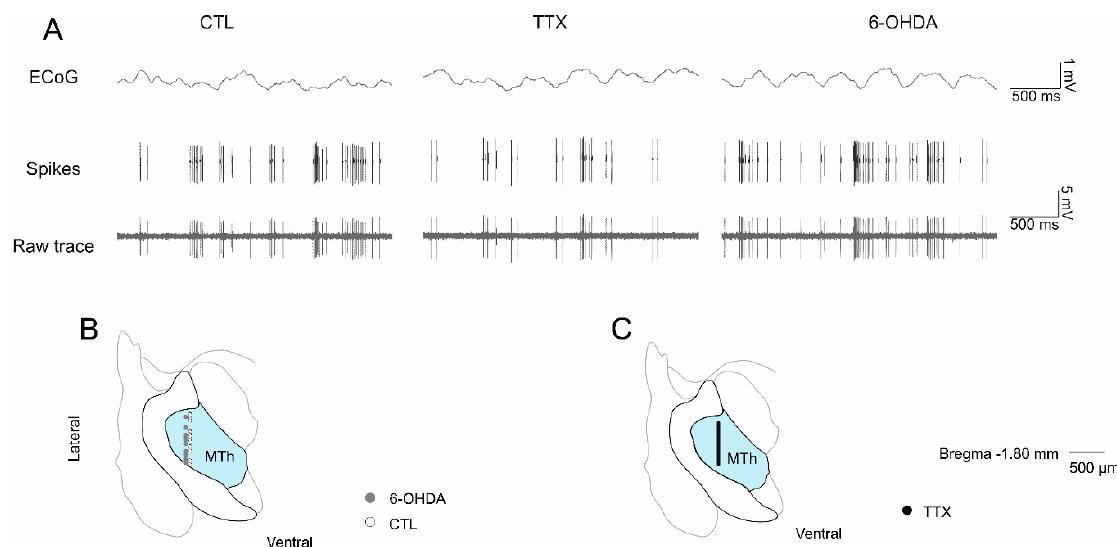
Figure 1. ( A ) Representative electrophysiological recordings of the three groups of animals. From the Table 6. hydroxydopamine (6-OHDA)-lesioned rats, respectively. ( C ) Histological reconstruction of the MTh recording site in tetrodotoxin (TTX)-treated rats (in blue). The black circles represent the recorded neurons in MTh during the TTX-mediated blockade of MFB.